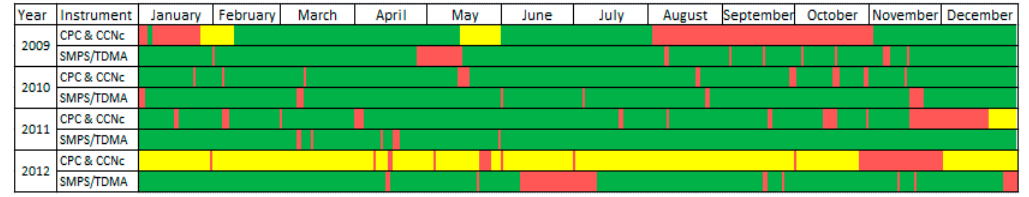
Figure 1. Data quality during the analysis period. Periods during which data are available and no significant problems were identified are colored green, those during which confidence in at least some subset of the data is low are yellow, and those during which data are unavailable or thought to be erroneous are red. Data used to generate this graph are available at the site identified in the Acknowledgments section below.